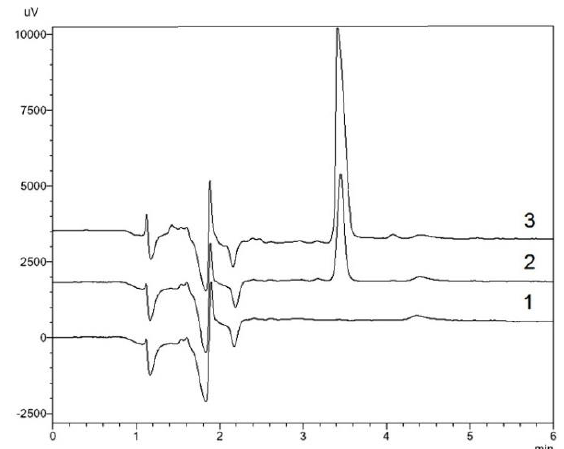
Fig. 2. Representative chromatograms obtained with placebo solution (1), reference solution (2), test solution (3) when determination of the fine particle dose of sal- butamol was performed (peaks with Rt=3,521 min and Rt=3,528 min correspond to